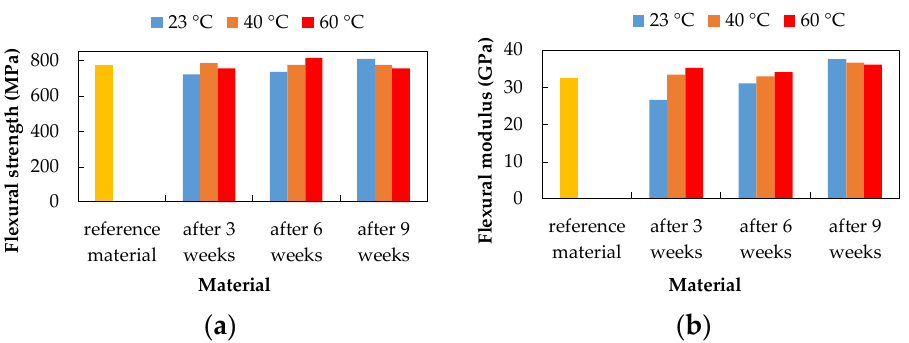
Figure 8. Influence of exposure to 20% NaCl at different temperatures on the CFRP composite; ( a ) flexural strength; ( b ) flexural modulus.